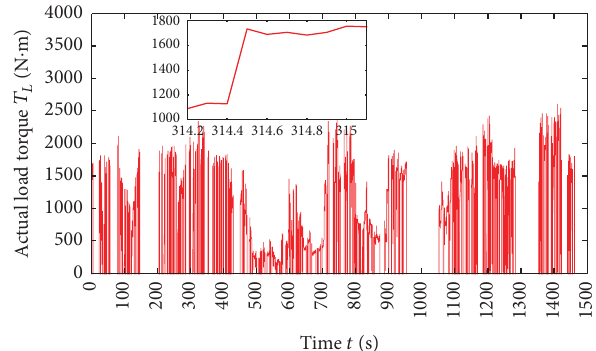
Figure 8: Field test data of external load torque.